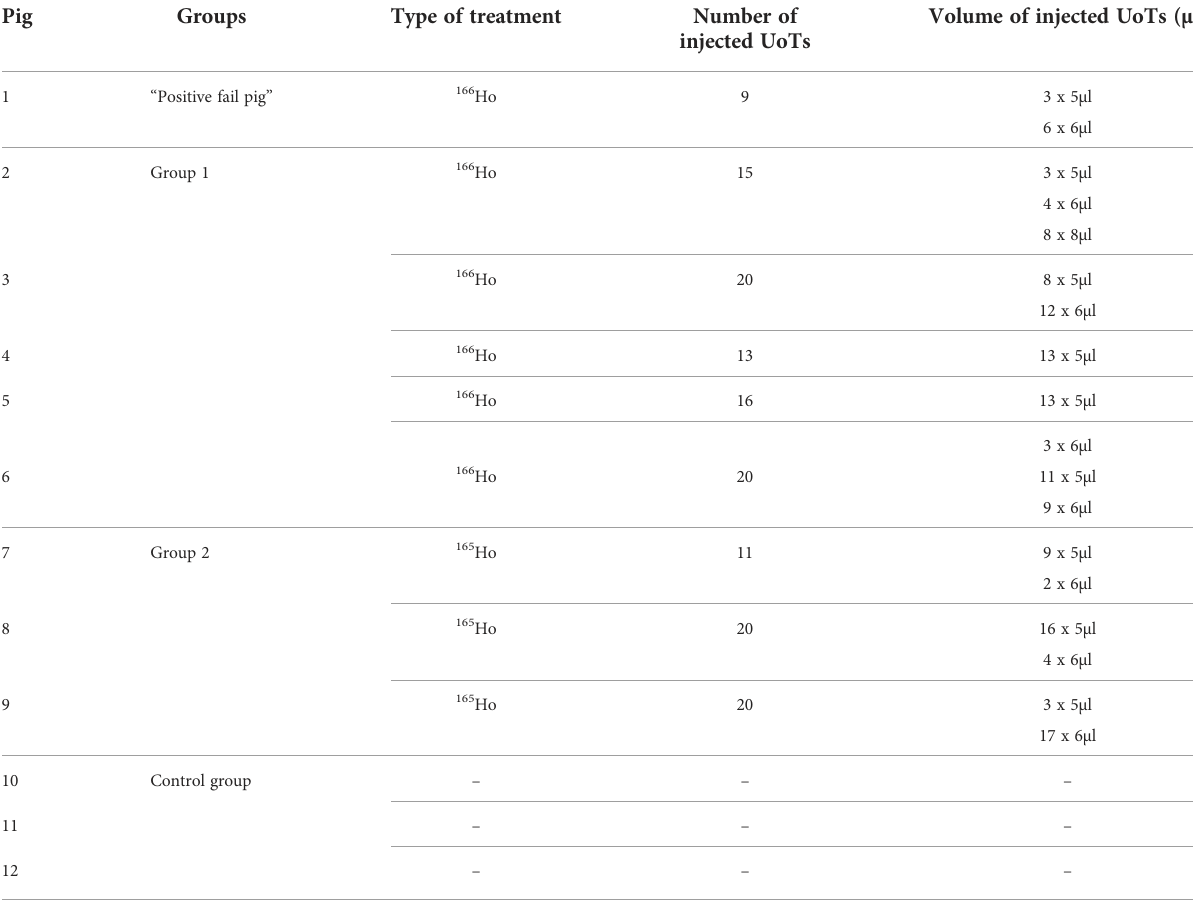
TABLE 1 Number and volume of unit of treatments (UoTs) injected in each animal. Pig Groups